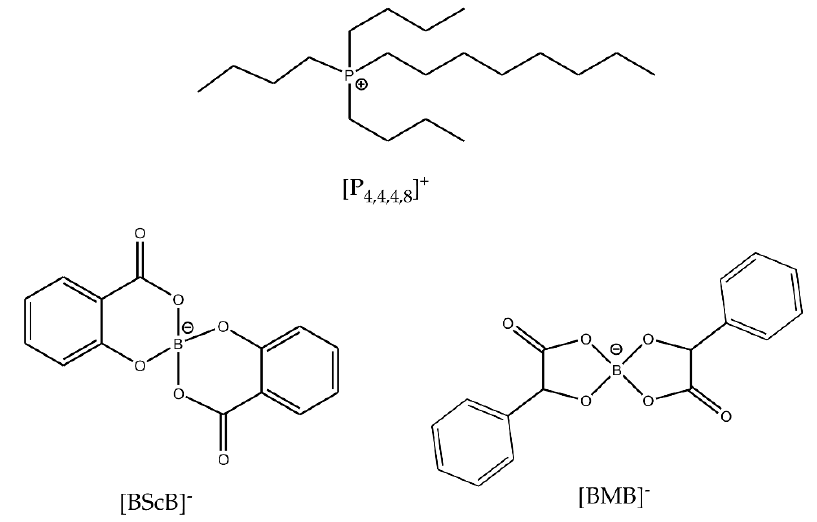
Figure 1. Chemical structures and abbreviations of the IL ions.